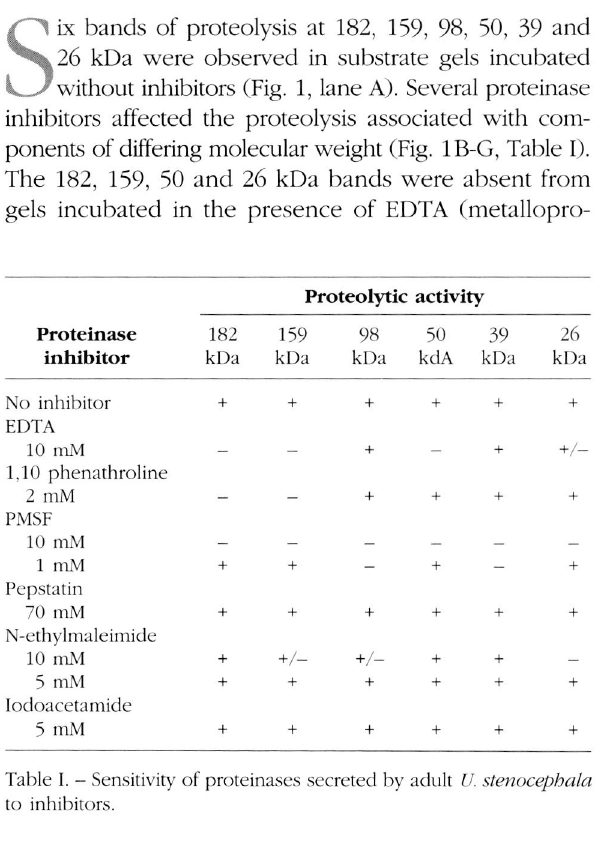
Table I. - Sensitivity of proteinases secreted by adult (7. stenocephala to inhibitors.